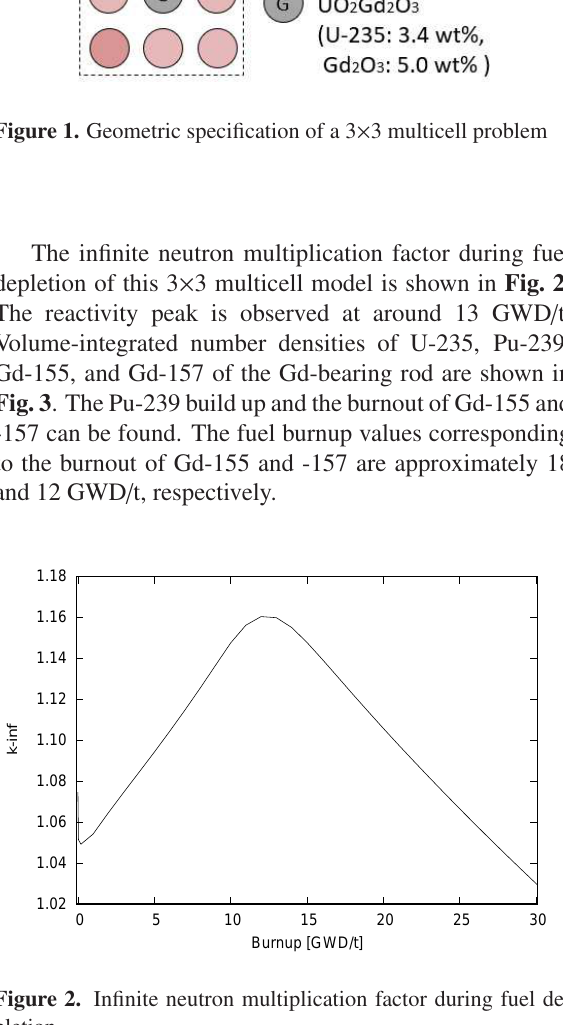
Figure 2. Infinite neutron multiplication factor during fuel de-